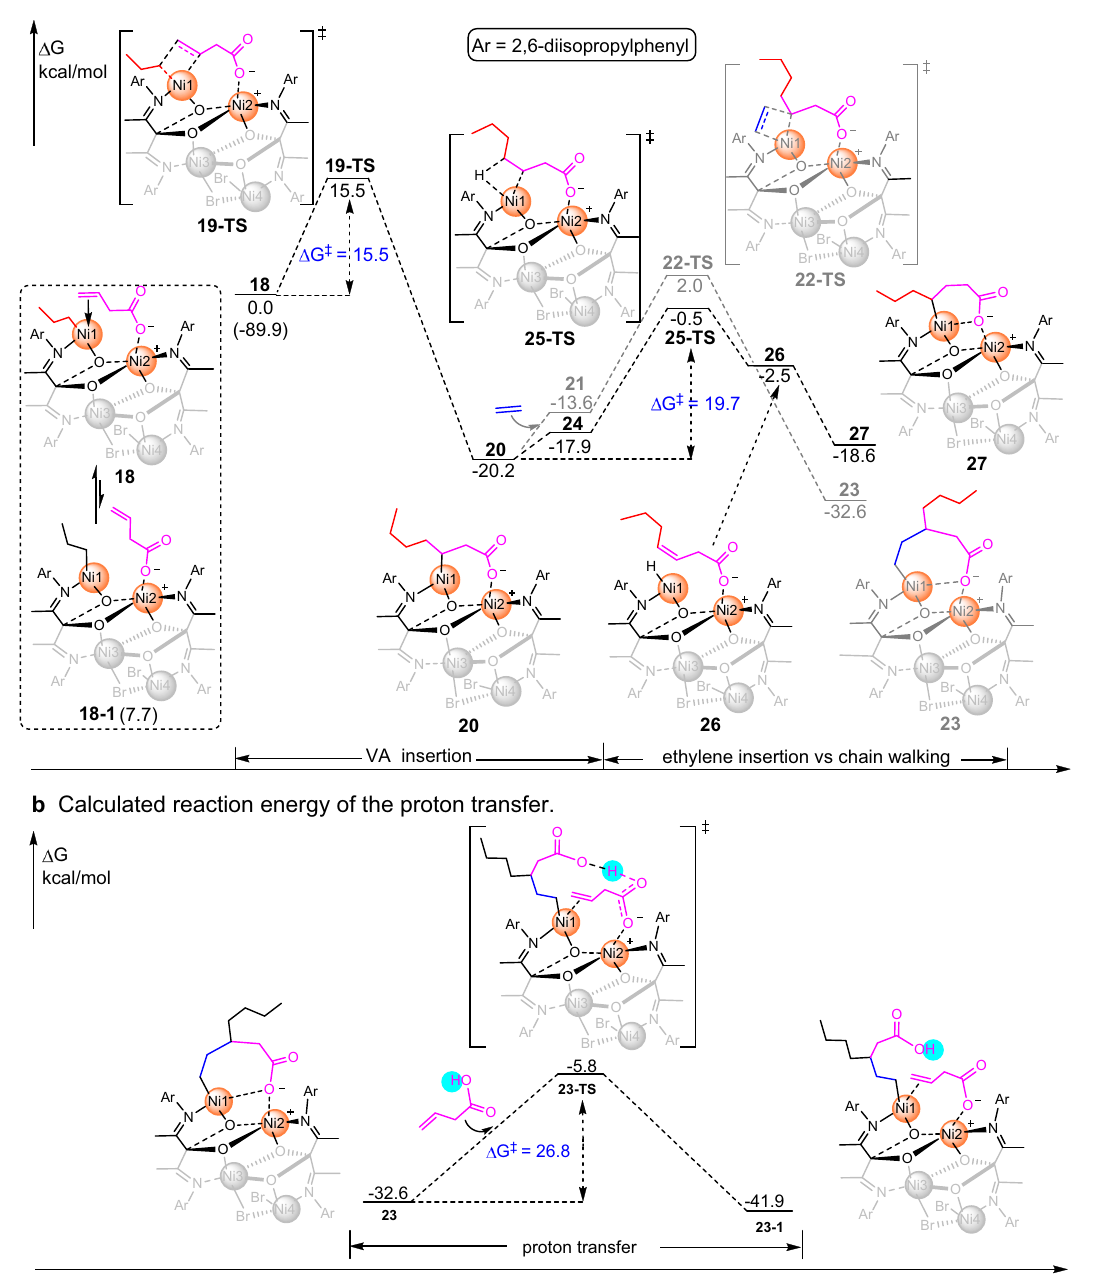
Fig. 3 DFT calculations. a Computed energy pro fi les (M06(SMD)/6-311 + G** ∩ SDD//B3LYP/6-31G* ∩ LANL2DZ, the solvent used in calculations is toluene) for Ni mediated copolymerization of ethylene with VA anion (the effect of large aluminum counterion was not considered). The energies are relative to the intermediate 18 . b Calculated reaction energy (M06(SMD)/6-311 + G** ∩ SDD//B3LYP/6-31G* ∩ LANL2DZ, the solvent used in calculations is toluene) of the proton transfer. The energies are relative to the intermediate 18